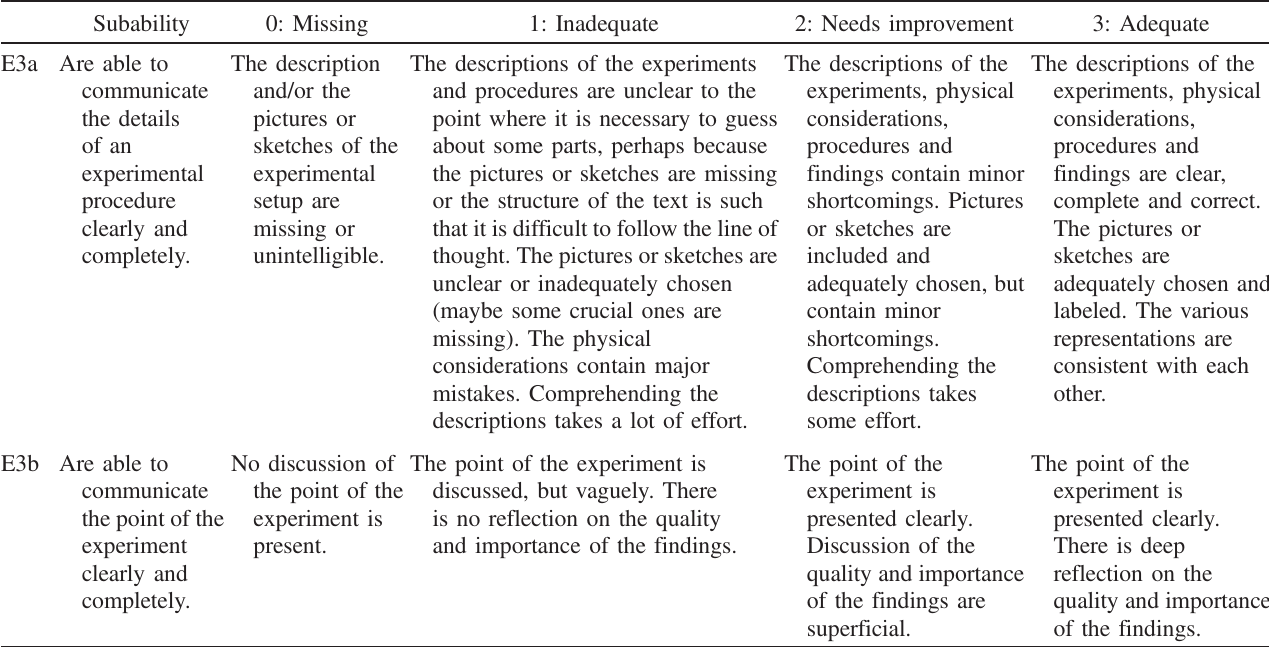
TABLE VI. The third and fourth lines of the new rubric for the ability of writing a report in the form of a web page. The subabilities E3a and E3b were joined together as E3 for some time during the rubrics period, but were soon split again into two separate subabilities.